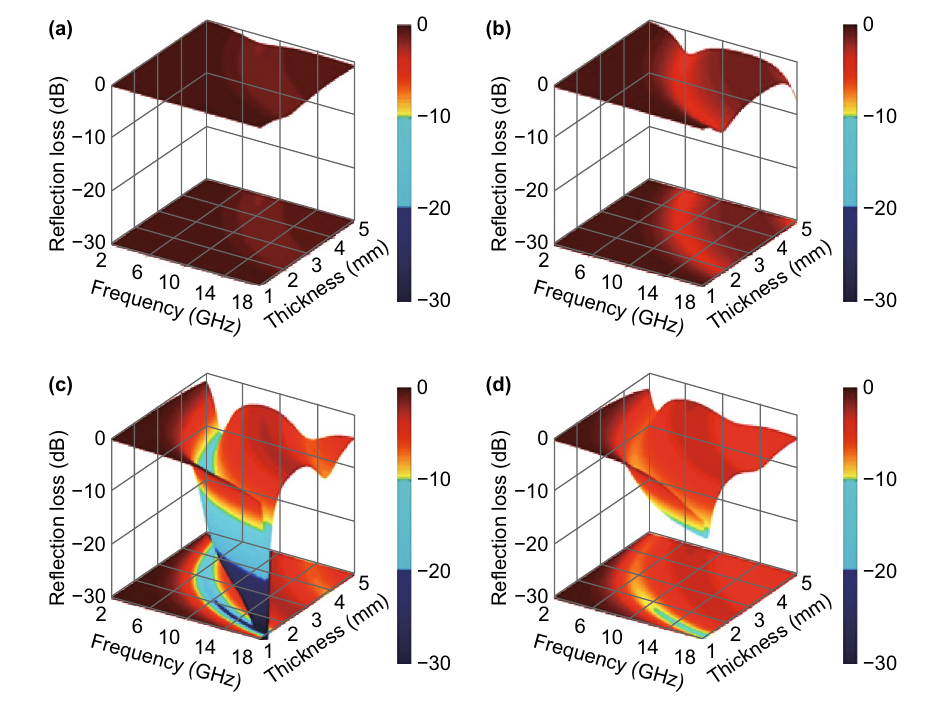
Fig. 6 Three-dimensional RL maps of a WCC-2, b WCC-4, c WCC-6, and d